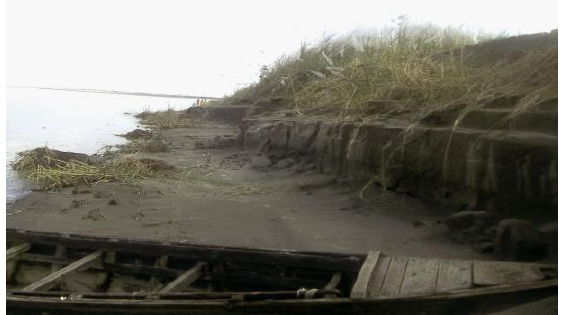
Figure 9. Vegetated bar erosion at Char Barul, Jamuna River, Jamalpur.